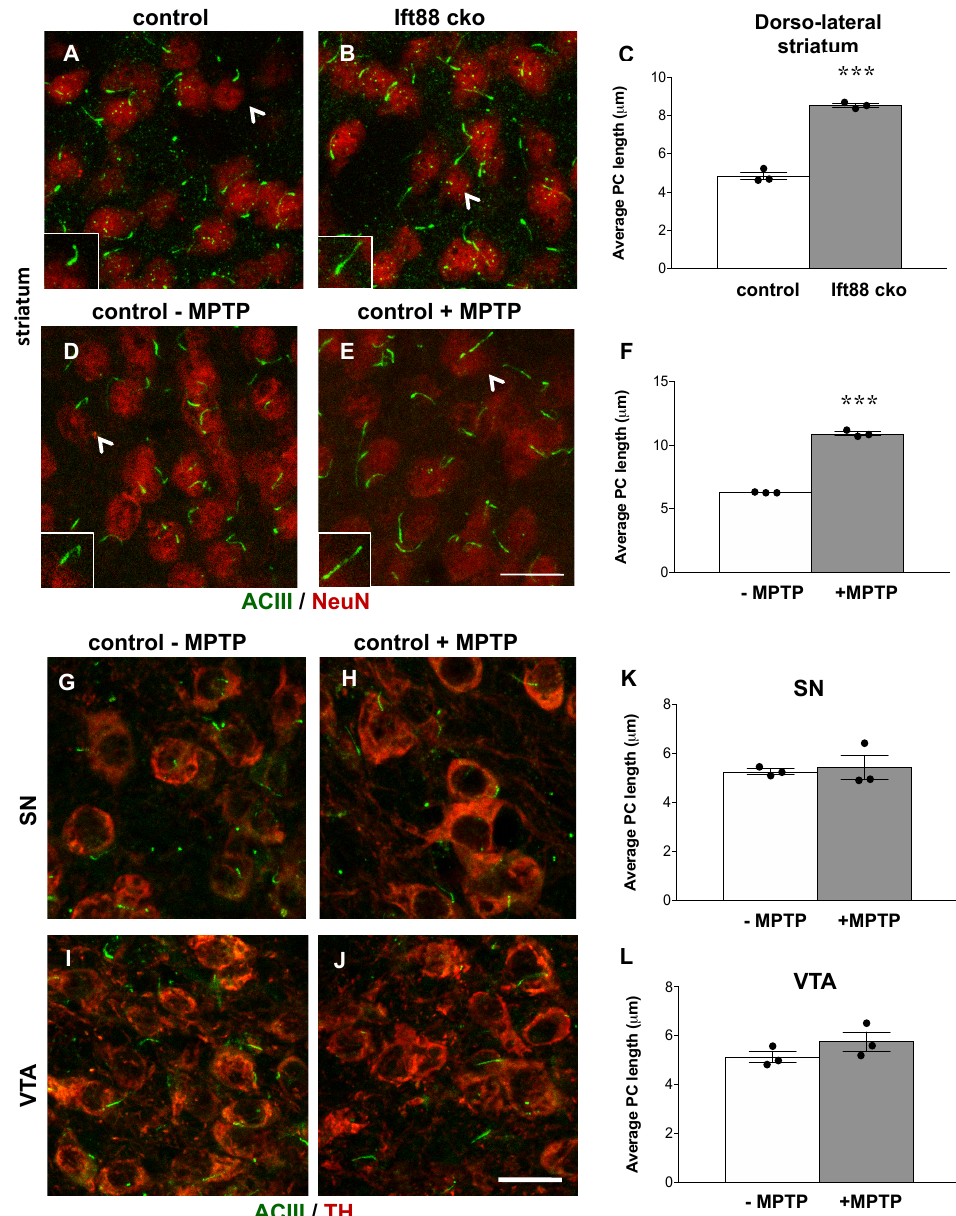
Figure 5. Loss of striatonigral integrity in the Ift88 cKO and in the MPTP models is associated Figure 5 with increased length of PC in striatal neurons. Representative confocal images of dorso-lateral striatal cryosections showing PC immunostained with an antibody recognizing ACIII (green) in NeuN positive neuronal nuclei (red) in control and Ift88 cKO mice ( A , B ) and in MPTP-treated and not treated controls ( D , E ). Quantification of the average PC length in dorso-lateral striatum in control and IftI88 cKO mice ( C ) and in control mice upon MPTP treatment ( F ). Arrows point to the PC shown in the inset. ( G – J ) Representative confocal images of ventral midbrain cryosections showing PC stained with an antibody recognizing ACIII (green) in TH positive neurons (red) of the SN and VTA in control mice non-treated and treated with MPTP. ( K , L ) Quantification of the average PC length in control mice upon MPTP treatment in SN and VTA. At least 80 cilia from each mouse were measured ( n = 3 mice per group). The data are presented as the mean ± SEM. Statistical significance between the indicated groups determined by unpaired two-tailed Student’s t -test, *** p < 0.001 (for details, see also supplementary statistical information). Scale bar: ( A , B , D , E , G – J ); insets: 12 µ